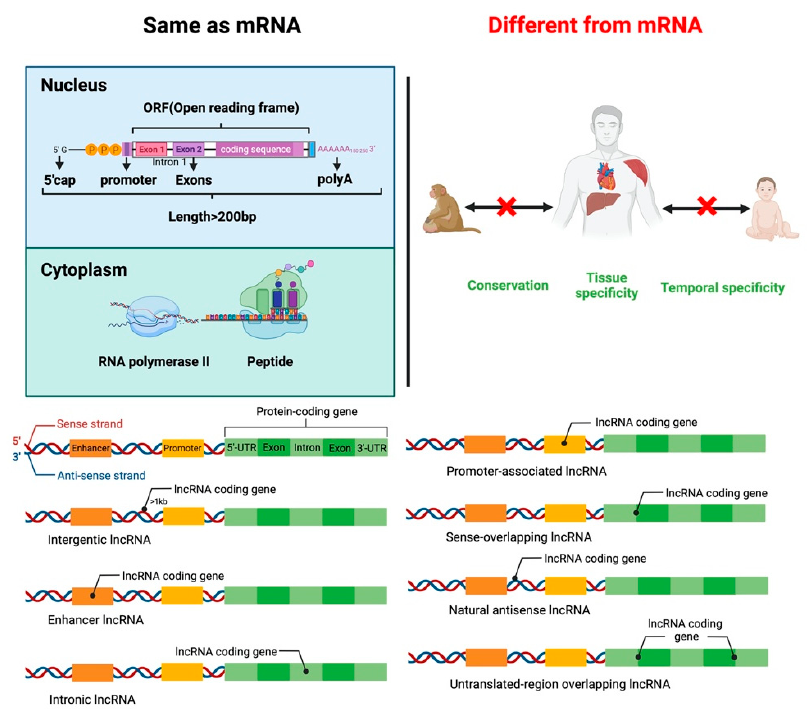
Figure 1. Similarities and differences between lncRNA and mRNA structure and function. Classification of lncRNAs according to the transcription position of the genome.